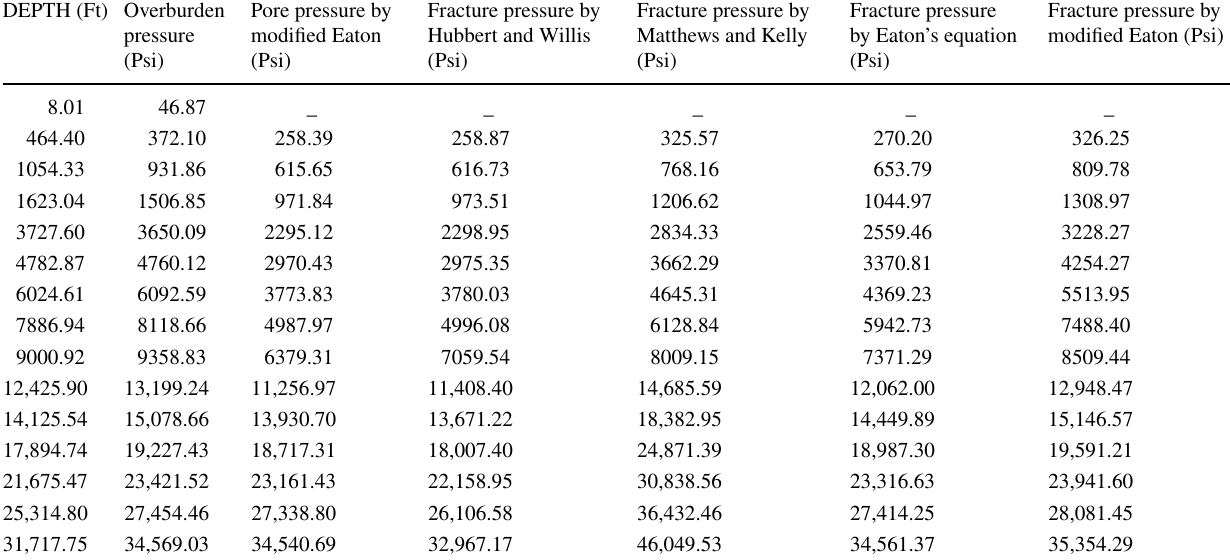
Table 10 Fracture pressure on the Tulamura anticline using pore pressure by the proposed new equation DEPTH (Ft) Overburden pressure